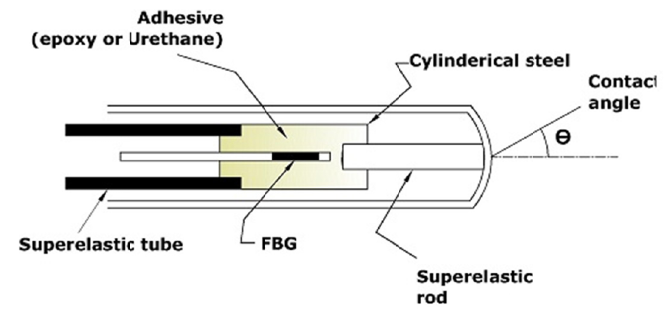
prototype se components